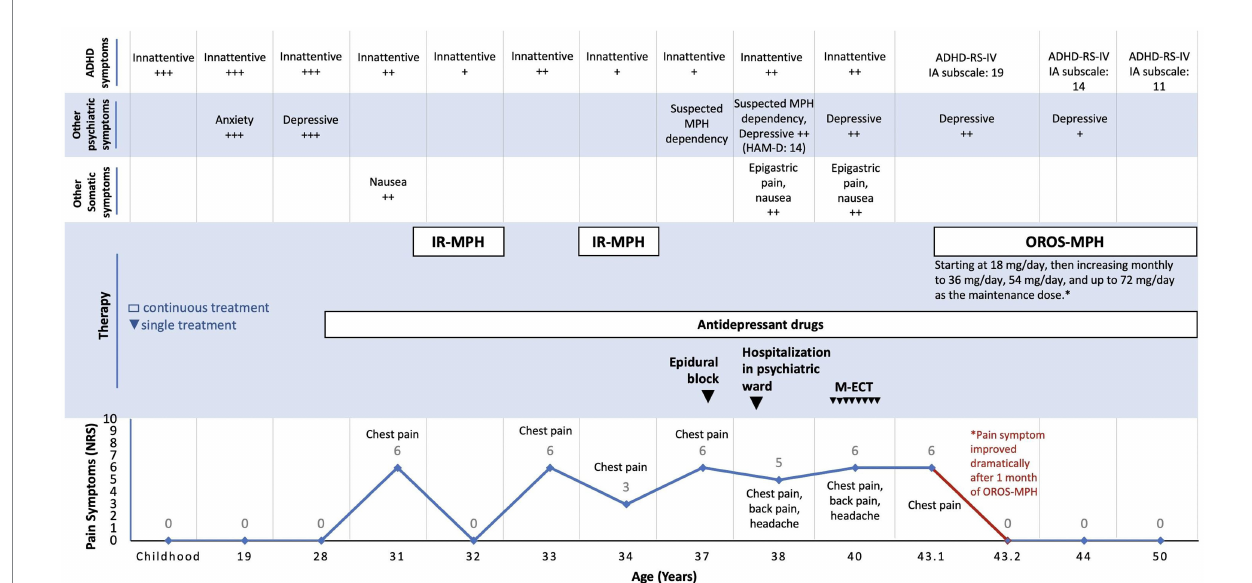
FIGURE 1 Timeline of clinical symptoms and therapies. ADHD, attention deficit hyperactivity disorder; NRS, numeric rating scales for pain; MPH, methylphenidate; IR-MPH, immediate-release methylphenidate; OROS-MPH, osmotic-release oral system methylphenidate; HAM-D, Hamilton depression rating scale; M-ECT, modified electroconvulsive therapy; ADHD-RS-IV, ADHD rating scale IV; IA,